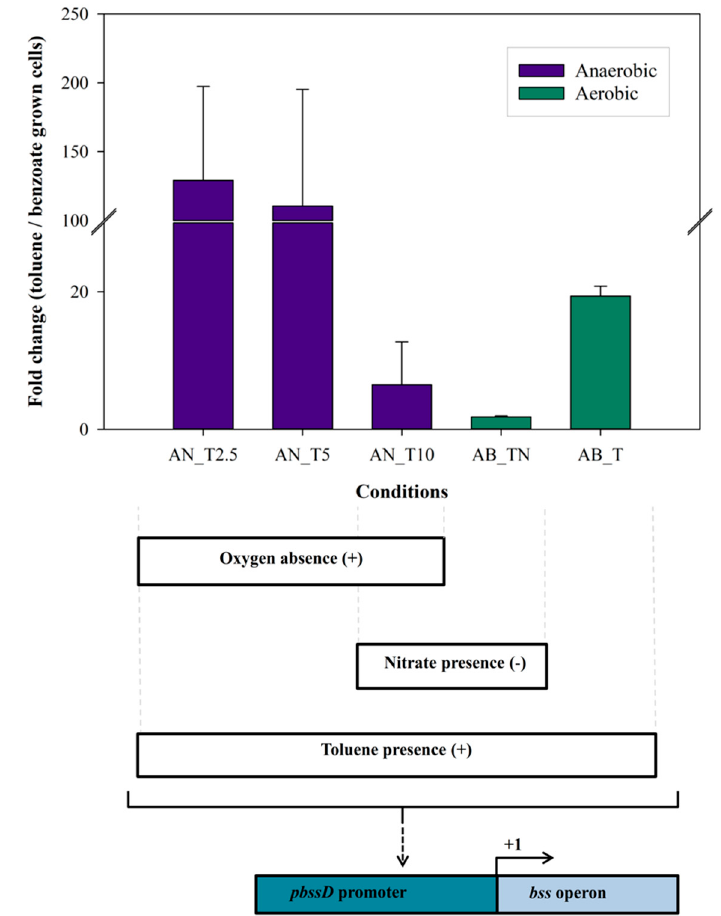
Figure 2. bssA expression in anaerobic and aerobic cultures of Magnetospirillum sp. 15-1. AN_T represents cultures growing anaerobically with toluene and either 2.5 mM (AN_T2.5), 5 mM (AN_T5), or 10 mM (AN_T10) of KNO 3 . AB_T represents cultures growing aerobically with benzoate and supplied additionally with either toluene alone (AB_T) or toluene and 5 mM of KNO 3 (AB_TN). The promoter ( pbssD of the bss operon) and the initiation of its transcription ( + 1) could be induced ( + ) or repressed (–) due to the presence of oxygen, nitrate, and toluene.